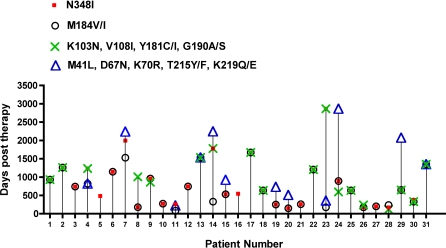
Pattern of Emergence of N348I Early in Drug Therapy FailureThe pattern of emergence of N348I relative to key drug resistance mutations in the RT is shown with respect to days post therapy. These patients had neither N348I nor key drug resistance mutations present at baseline. Mixtures of WT and mutants were considered mutant in this analysis. The presence of the indicated key mutations was included from data available from each time point up to the appearance of N348I. If subsequent time points also contained N348I, then the key mutations present at this time point was also included in the analysis.